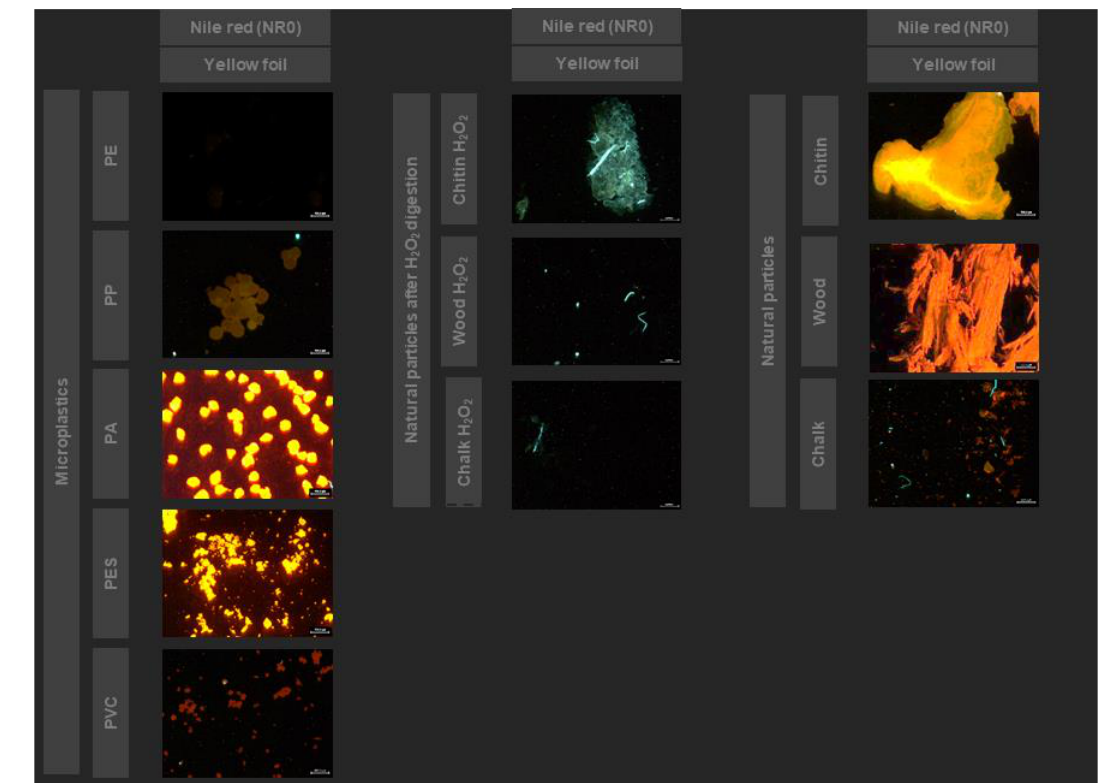
Figure 4. Fluorescent images of microplastics and natural particles stained with NR0 (Nile red) taken with the low budget modification of the microscope Additionally, for the natural particles, the effect of the hydrogen peroxide treatment (see Section 2.5) is visualized.